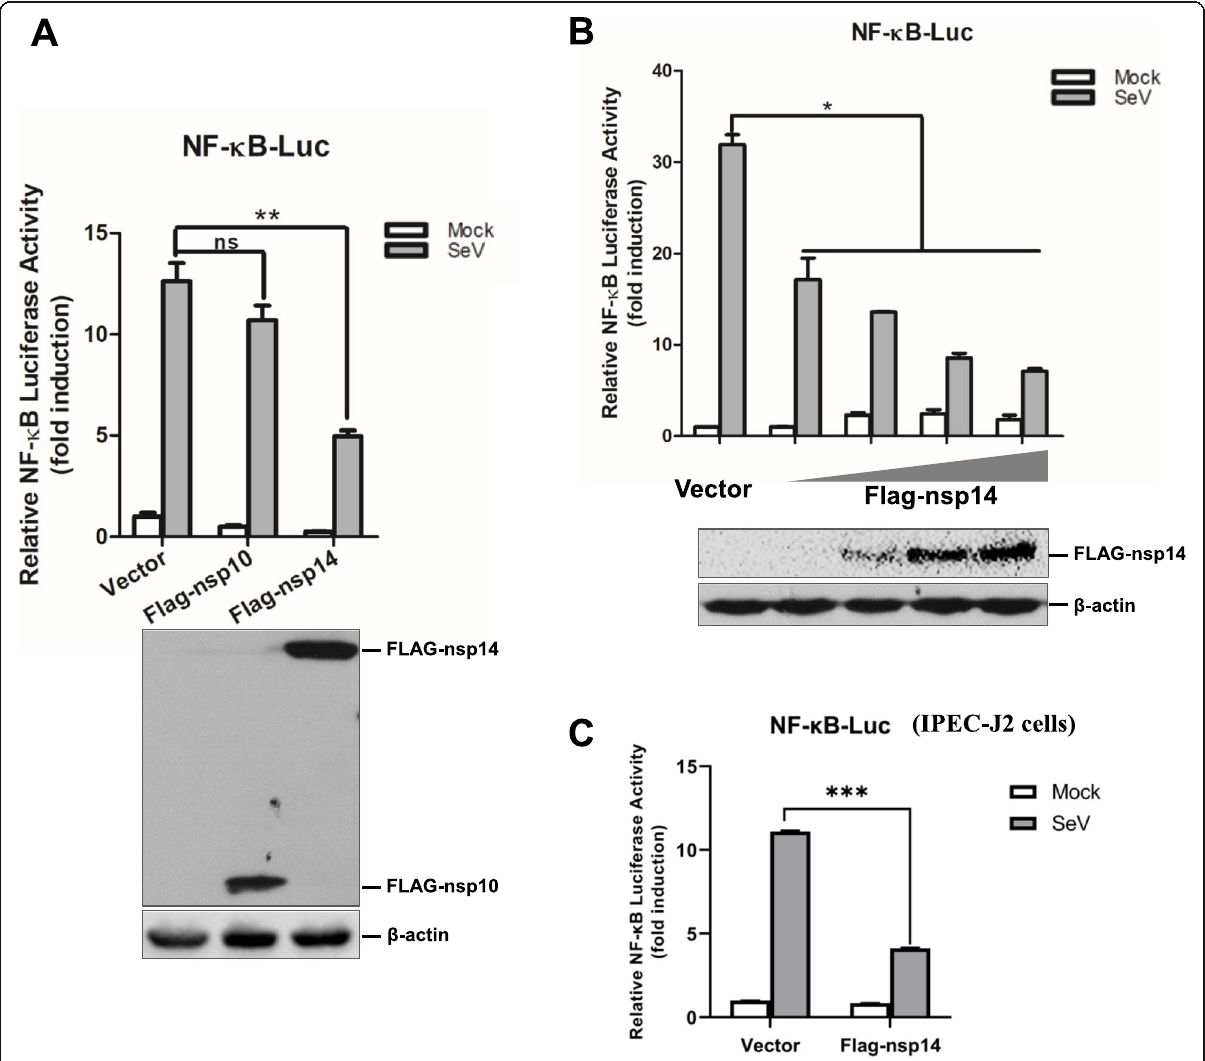
Fig. 1 PEDV nsp14 inhibites NF- κ B promoter activation. A HEK-293T cells were transfected with pNF- κ B-Luc reporter plasmid (0.05 μ g) and pRL- TK plasmid (0.005 μ g) together with empty vector plasmids or plasmids expressing PEDV nsp10 or nsp14 (0.1 μ g) for 24 h. Cells were then mock- infected or infected with SeV for another 16 h, and luciferase activities were measured. Expression of nsp10 and nsp14 was analyzed by Western blotting using an anti-Flag antibody. B HEK-293T cells were transiently transfected with pNF- κ B-Luc reporter plasmid (0.05 μ g) and pRL-TK plasmid (0.005 μ g) together with increasing amounts of plasmids expressing PEDV nsp14 (0, 0.01, 0.05, 0.1 or 0.2 μ g). At 24 hpt, cells were mock- infected or infected with SeV for another 16 h. Luciferase activities were measured using a dual luciferase reporter assay. Expression of nsp14 was analyzed via Western blotting with an anti-Flag antibody. Data are expressed as the means ± SD from three independent experiments. *, P < 0.05 ; **, P < 0.01 . ns indicates not significant. C IPEC-J2 cells were transiently transfected with pNF- κ B-Luc reporter plasmid and pRL-TK plasmid together with empty vector plasmids or plasmids expressing PEDV nsp14 for 24 h. Cells were then mock-infected or infected with SeV for